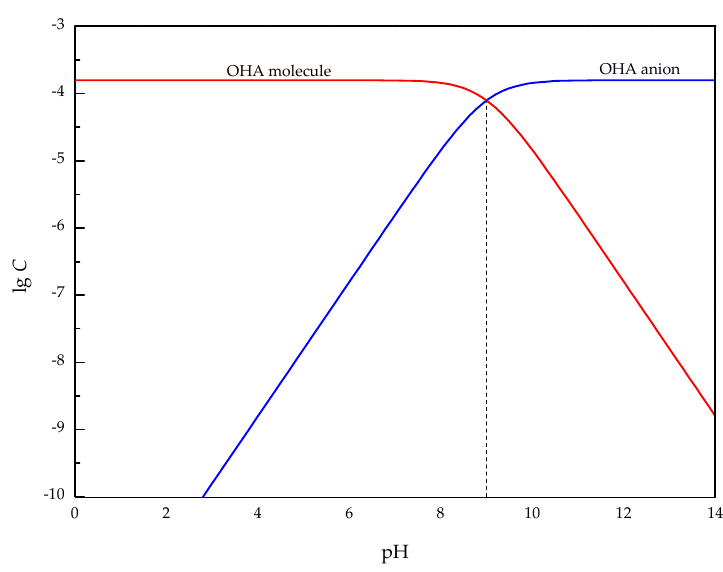
Figure 10. Logarithmic diagram of octyl hydroxamate acid hydrolysis components ( c OHA = 1.5 × 10 − 4 M).